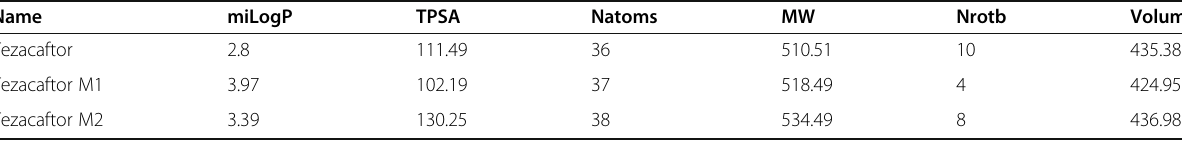
Table 14 Molinspiration calculation of Tezacaftor and its metabolites